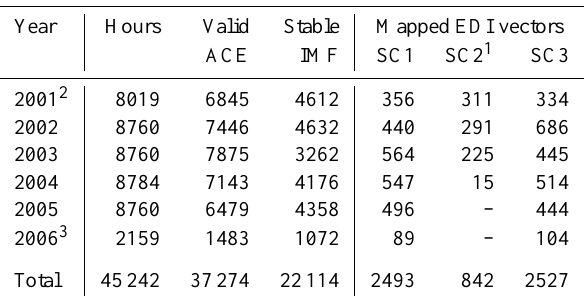
Table 1. Data coverage in hours of observations for the present